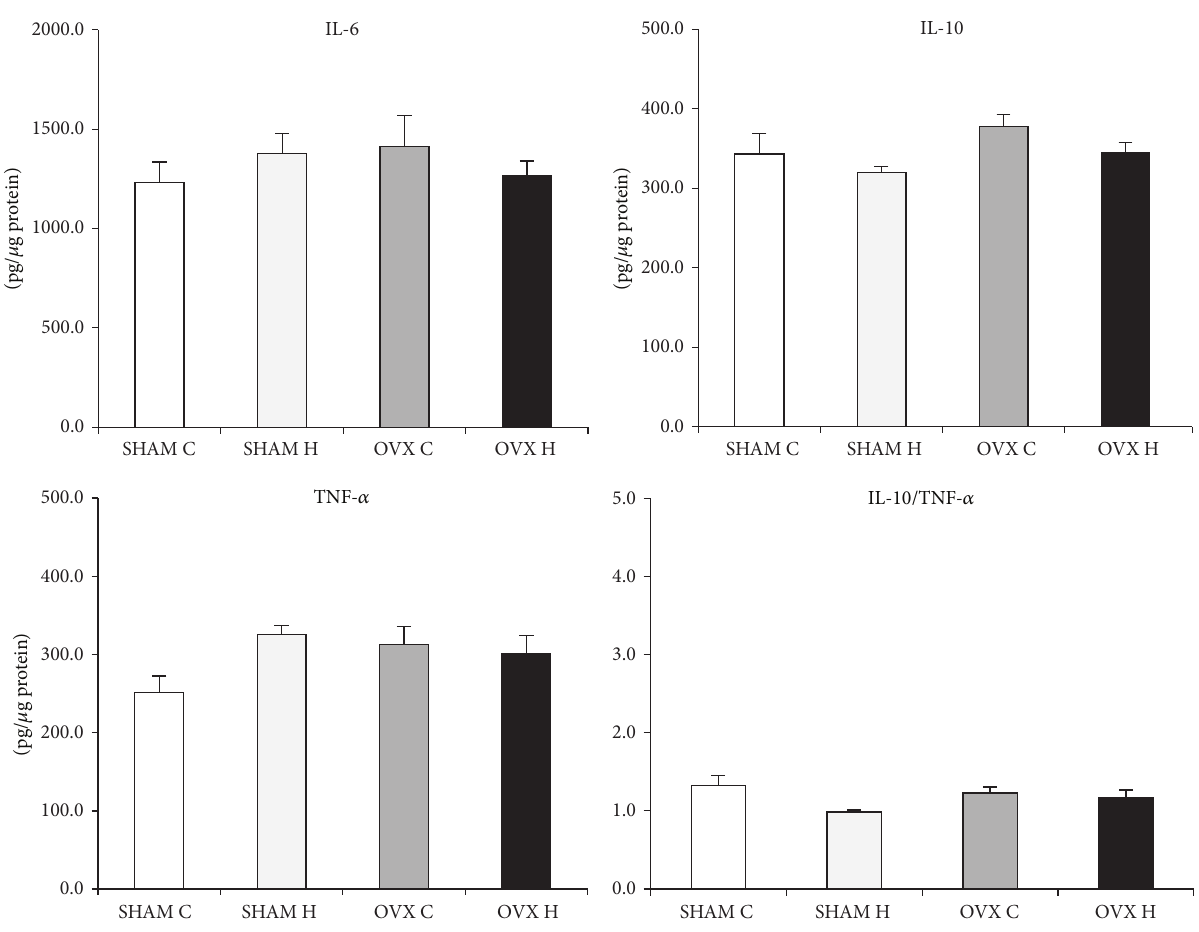
Figure 2: Liver cytokines content of studied rats groups: (SHAM C) sham group treated with control diet; (SHAM H) sham group treated with hyperlipidic diet; (OVX C) ovariectomized group treated with control diet; (OVX H) ovariectomized group treated with hyperlipidic diet. The numbers of samples varied between six and